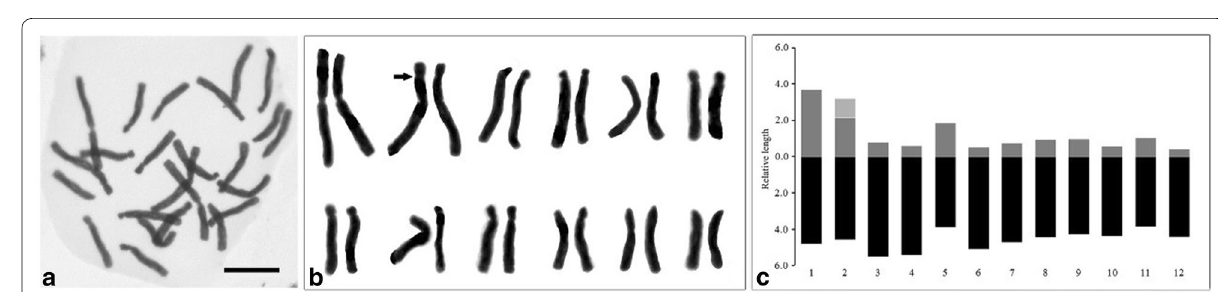
Fig. 4 Karyotype analysis of Lilium callosum . a Somatic mitotic metaphase chromosomes (2n secondary constriction. c Idiogram. The relative length of each chromosome is on the